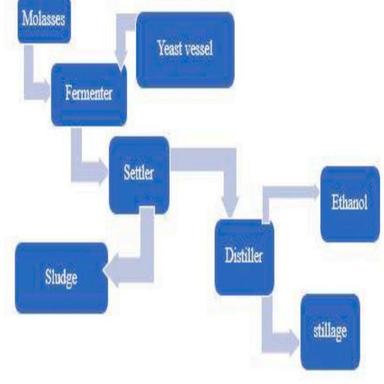
The conventional molasses-based ethanol production process.